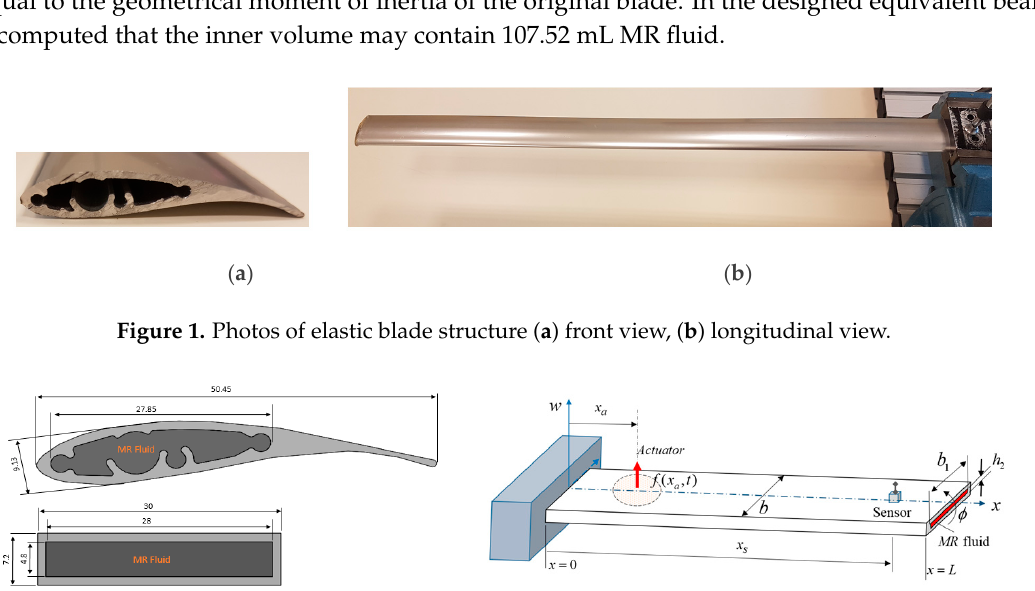
Figure 2. Dimensions of the blade profile ( a ) cross section (mm), ( b ) the equivalent beam model.